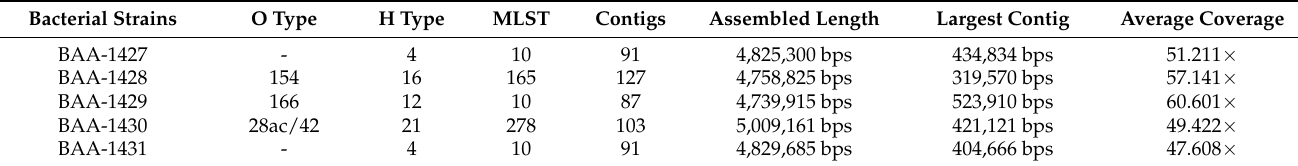
Table 2. Short-read Illumina MiSeq assembly sequence